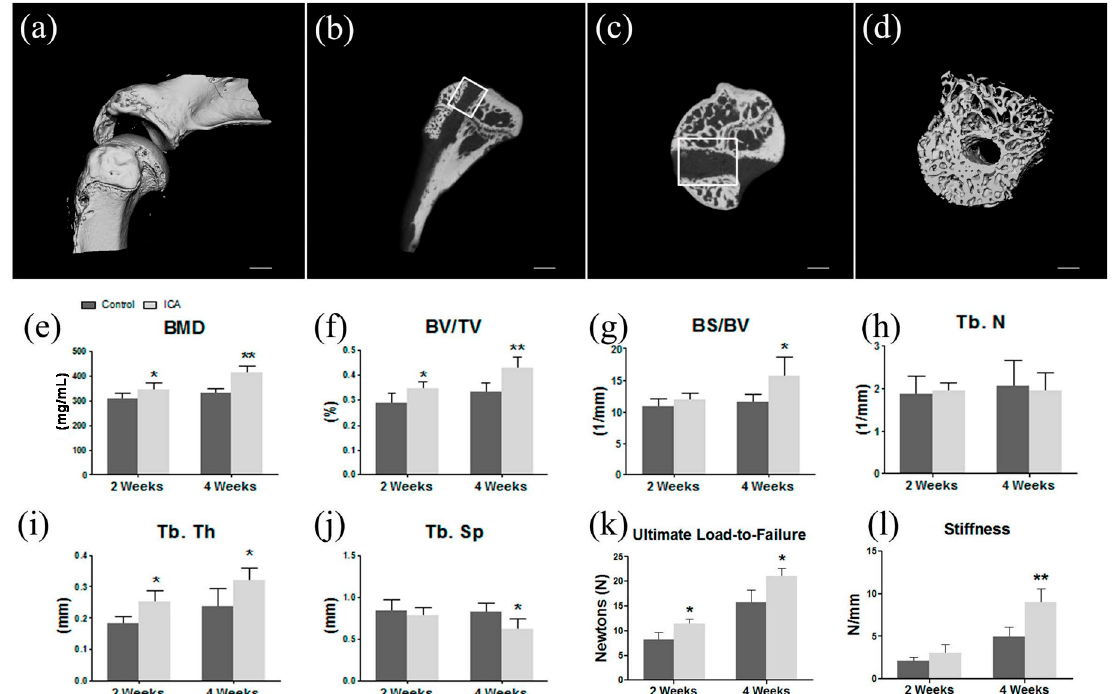
Figure 1. A sketch map and results of the micro-CT evaluations and biomechanical testing: ( a ) Gross observation of specimen containing the supraspinatus and humerus of the surgical side in a three-dimensional reconstruction micro-computed tomography (micro-CT) image; ( b ) The vertical plane of the axis of the humerus bone tunnel in a sagittal view on the micro-CT image; new bone formation in the region of interest (ROI) within the bone tunnel, and the bone density at the tendon insertion site on the greater tuberosity, was revealed and evaluated (white rectangle); ( c ) Cross section of the axis of the humerus bone tunnel on the micro-CT image; the ROI is shown with new bone within the bone tunnel (white rectangle); ( d ) The cylinder scope including the bone tunnel with a diameter of 1.5 mm and depth of 3.0 mm from the joint surface in a three-dimensional reconstruction micro-CT image; ( e – j ) The results of micro-CT analysis revealed that ICA treatment effectively improved the bone quality. BS/BV: bone surface/volume ratio; BV/TV: bone volume fraction; Tb.Th: trabecular thickness; Tb.Sp: trabecular separation; Tb.N: trabecular number; ( k , l ) At two weeks, the mean ultimate load-to-failure was significantly higher in the ICA group compared with the control group. There was no significant difference in stiffness at two weeks between the two groups. At four weeks after operation, the average failure load and mean stiffness in the ICA group were significantly greater than in the control group. Scare bar = 1 mm. * p < 0.05 vs. the control group; ** p < 0.01 vs. the control group.